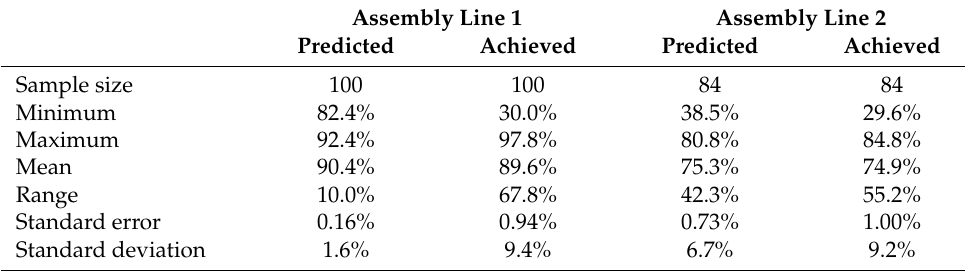
Table 4. Descriptive statistics OEE values for assembly line 1 and assembly line 2.